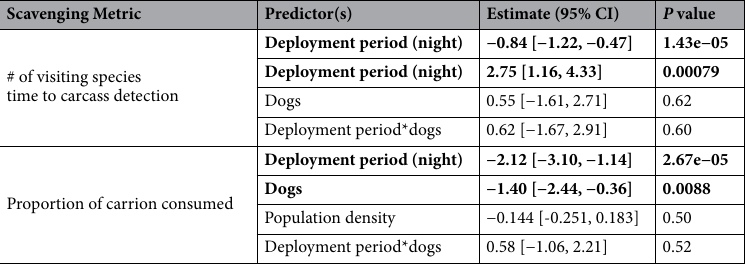
Table 3. Model-averaged effect sizes for top predictors of scavenging efficiency on ocean-exposed beaches in New Jersey, USA. Models reporting a (cid:31) AIC c < 2 were included in the analysis. Significant effects are in bold.